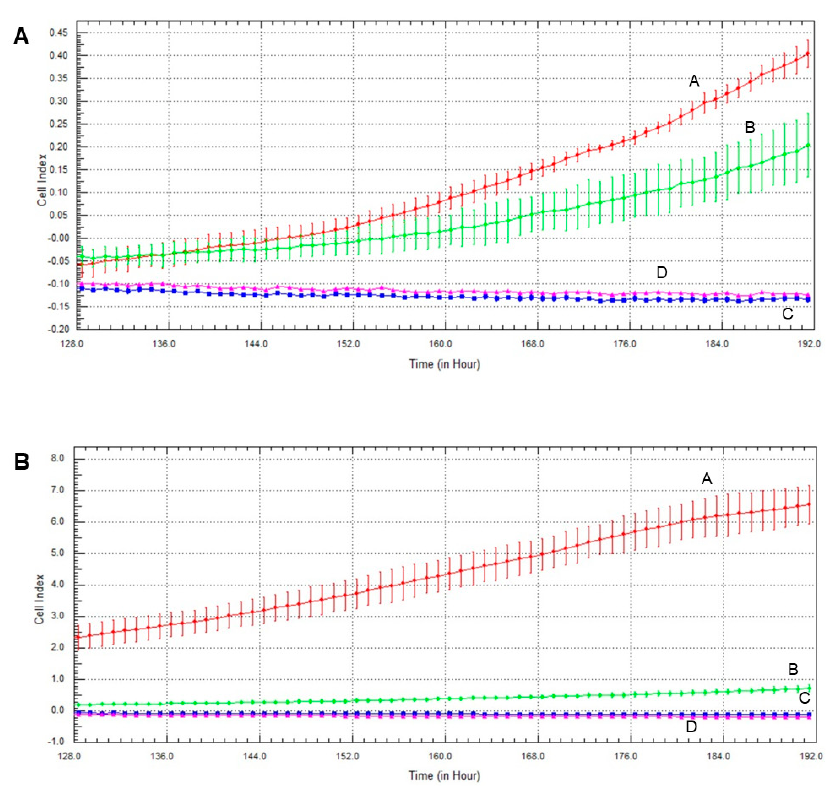
Figure 7. Effects of olaparib, oxaliplatin and LY294002 on invasive growth of MDA-MB-231 ( A ) and MCF7 ( B ) cells treated with 2 µ M olaparib, 25 µ M oxaliplatin and 1 µ M LY294002. Line A—control, Line B—1 µ M LY294002 treatment, Line C—2 µ M olaparib and 25 µ M oxaliplatin, Line D—combination treatment of 1 µM LY294002, 2 µM olaparib and 25 µM oxaliplatin.